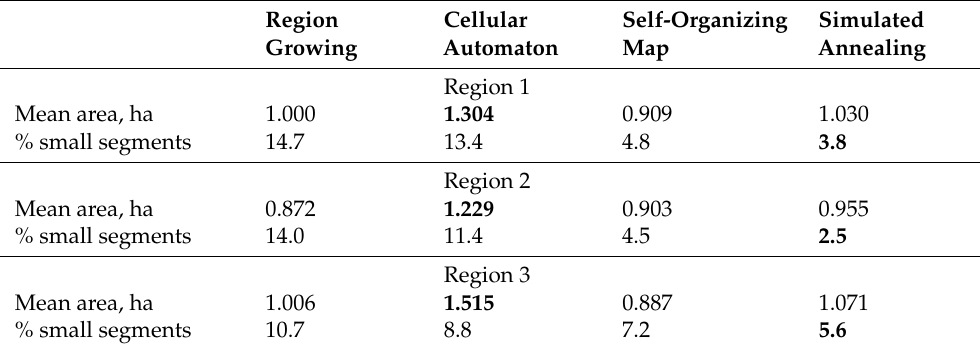
Table 3. Mean segment area and other statistics related to the size of segments. The method with the best value of the statistic is in